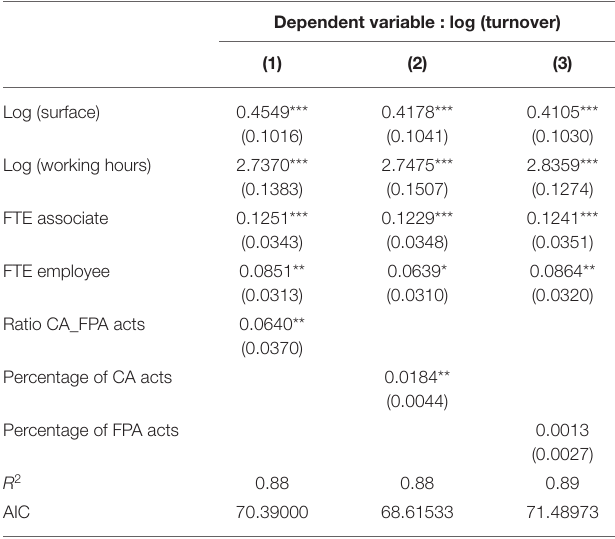
TABLE 8 | Results of the models of the association between the variables characteristic of the veterinarians and the weighted time to perform CA acts (1) and FPA acts